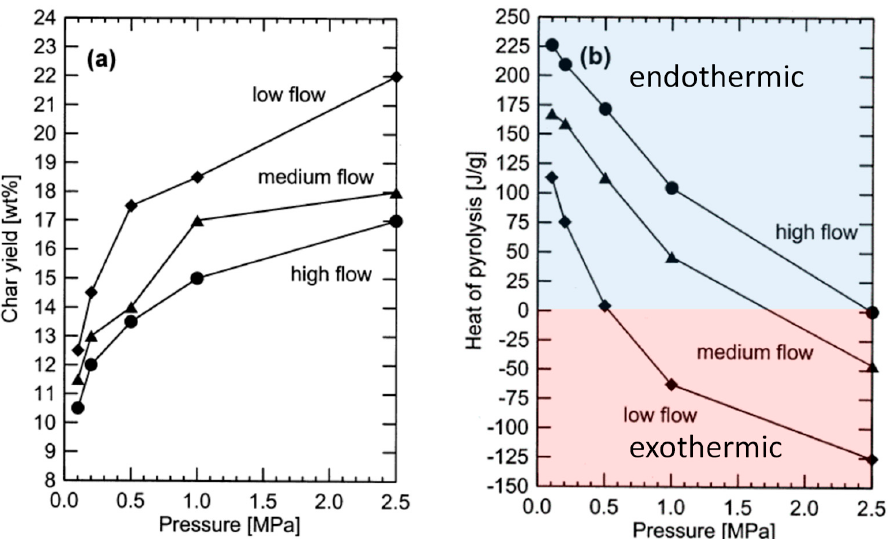
Figure 6. Char yield ( a ) and enthalpy for pyrolysis ( b ) as functions of operating pressure and venti- lation rate during slow pyrolysis of biomass. (Adapted with permission from ref. [29]. Copyright 2014 Thermochimica Acta).